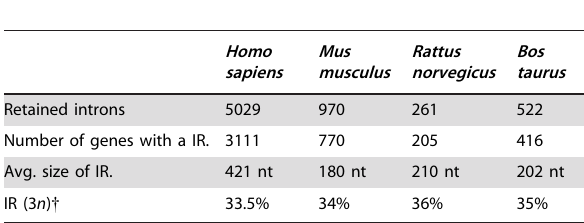
Table 5. Retained introns (IRs) with a premature stop codon that not target the mRNA for